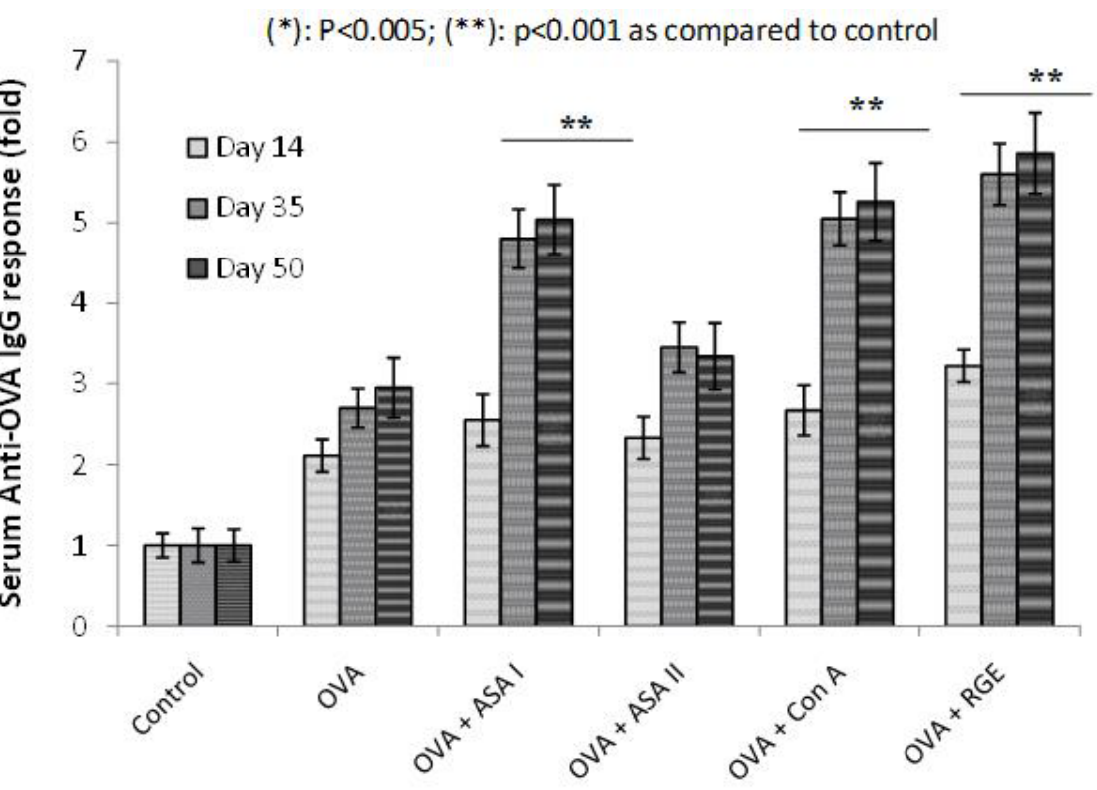
Figure 6. Ovalbumin (OVA)-specific IgG mucosal immune response to intranasal administration of OVA alone, or after OVA, co-administered with garlic components (ASA I or ASA II or RGE) or Con A by intranasal route at different times of administration. Coating antigen (10 µ g OVA in 100 μ L/well) overnight, washed, blocked with BSA, and incubated with test serum. Detection was with goat anti-mouse IgG-alkaline phosphatase conjugated antibody and PNPP substrate. The IgG response is represented as a fold increase taking the absorbance of the control as 1; serum dilution: 1:10; ** p < 0.001 vs. control. Each value is presented as mean ± S.D. ( n = 3).